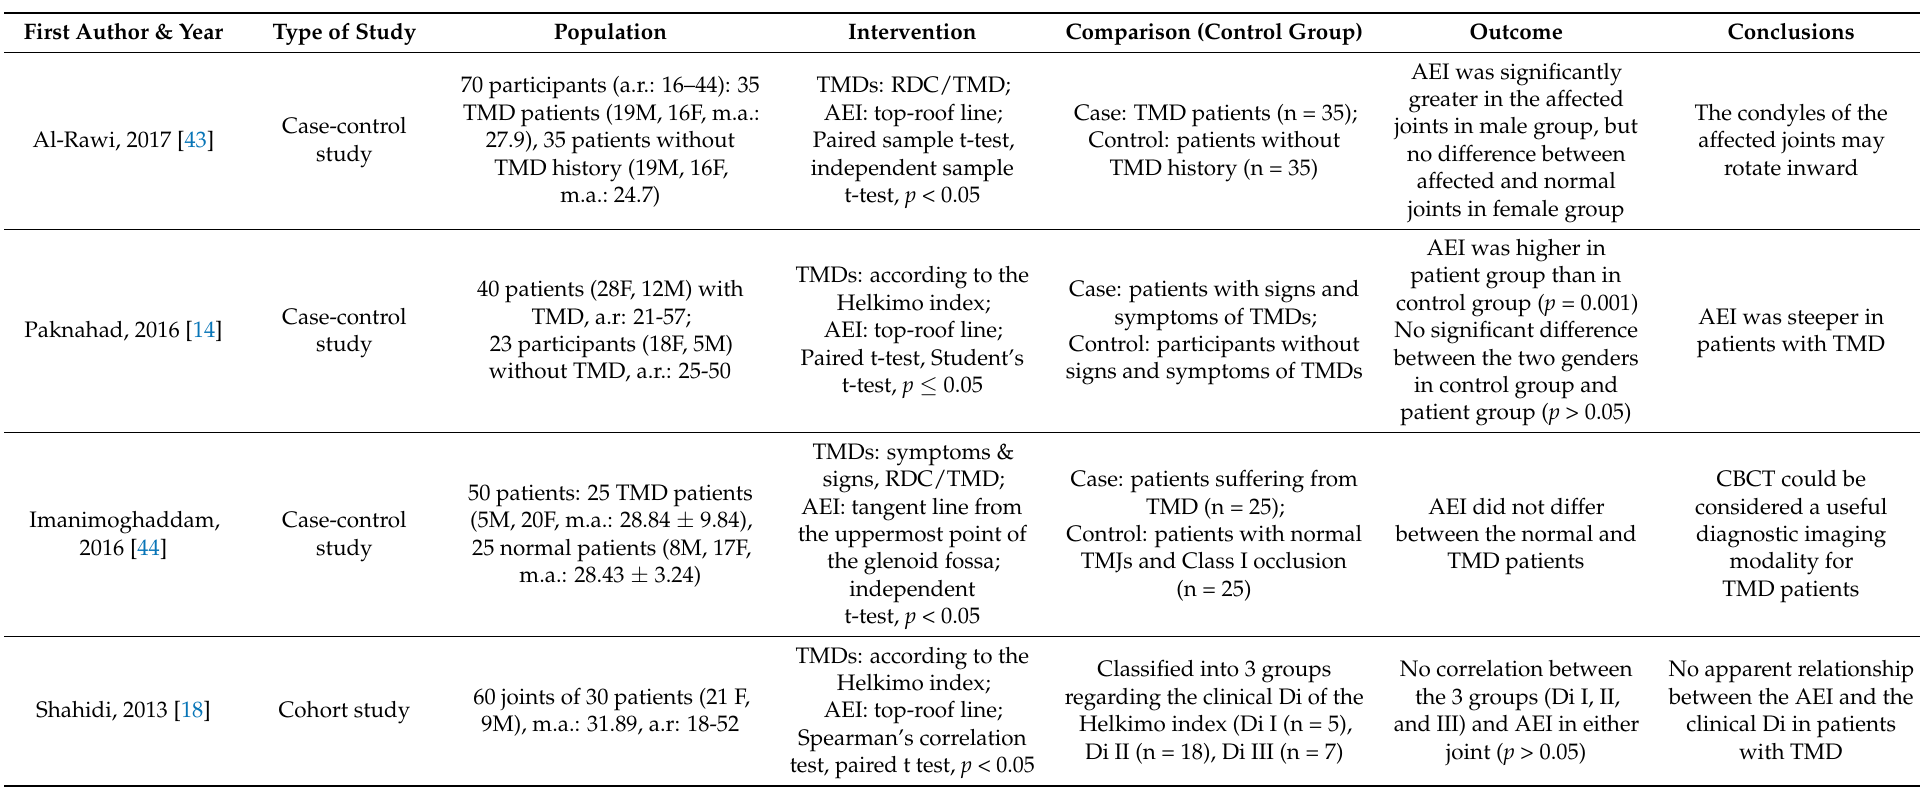
Table 4. Summary of findings from studies of TMDs and AEI with CBCT or Helical